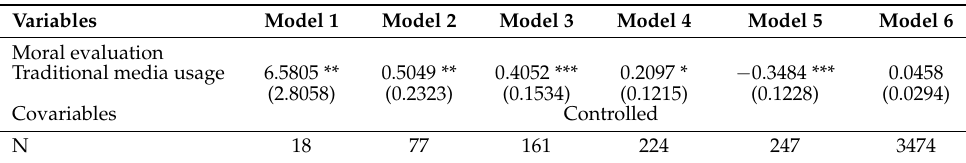
Table 5. The results of heterogeneity of different religious